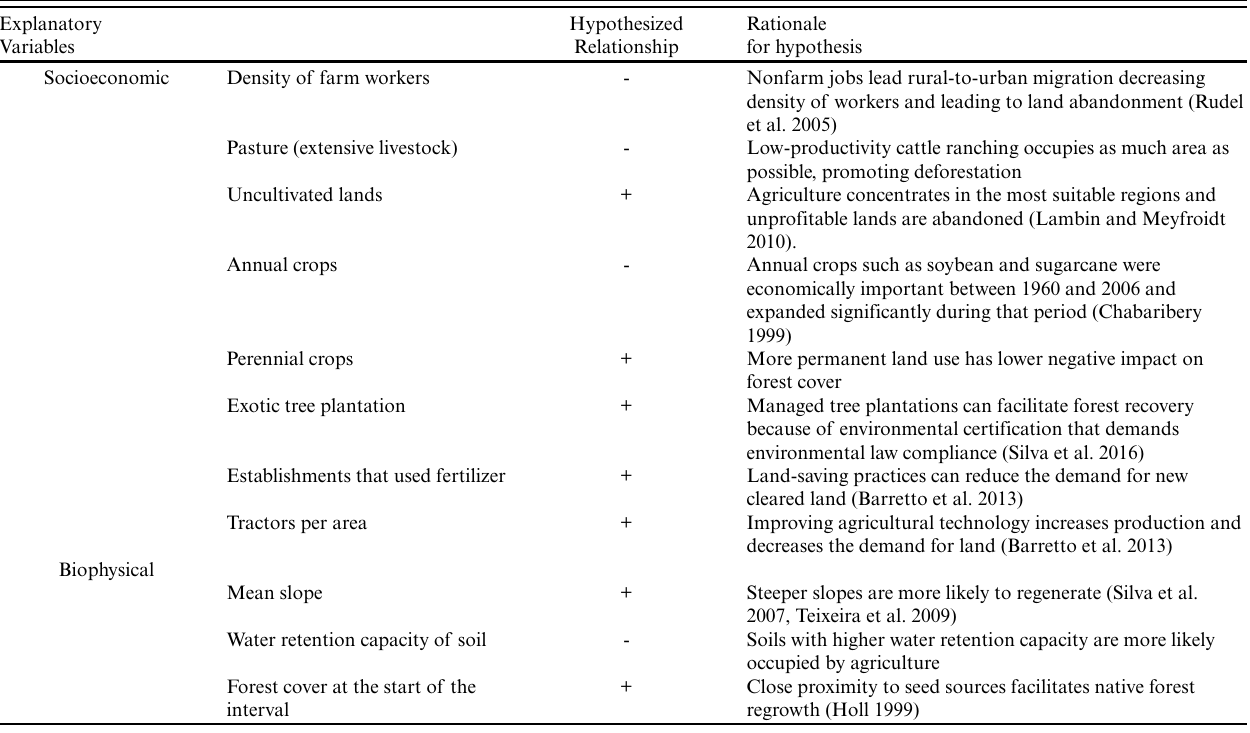
Table 1 . Explanatory variables considered in the models and hypothesized relationship between forest cover change and each of the drivers. The hypothesized relationship is indicated as positive (+) when the driver is expected to be associated with forest gains or negative (-) if associated with forest loss. All explanatory variables were included in the models as a ratio to account for drivers’ variation during each of the time periods (1960–1970, 1970–1980, 1980–1996, and 1996–2006), except for slope, soil water retention capacity, and percentage of forest cover at the start of the